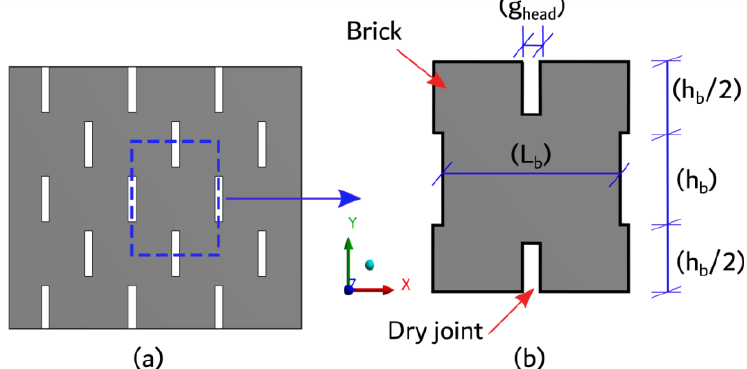
Figure 4. Schematic of ( a ) periodic mortarless masonry structure in state 3 and ( b ) unit cell used in the present study.